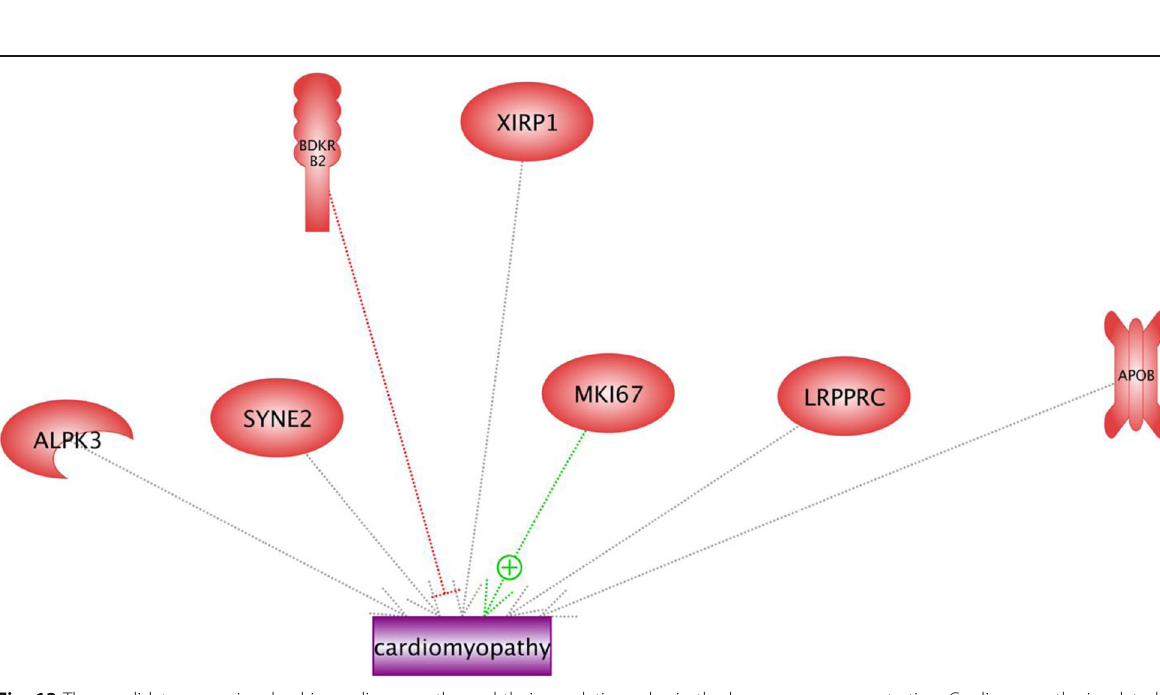
Fig. 13 The candidate genes involved in cardiomyopathy and their regulation roles in the low oxygen concentration. Cardiomyopathy is related to the abnormal formation of muscle heart and leads to the hypertrophic muscle. Heart muscle cells are sensitive to the low oxygen concentration that results in the death of cardiac myocytes. Results of this study showed that MKI67 induces cardiomyopathy, and BDKRB2 inhibits the disorder. MKI67 gene encodes the nuclear protein, which is related to cellular proliferation and might also play a role in the chromatin organization; however, it is poorly understood. The regulatory roles of other enriched genes in cardiomyopathy networks (including SYNE2 , APOB , XIRP1 , ALPK3 , and LRPPRC) are not